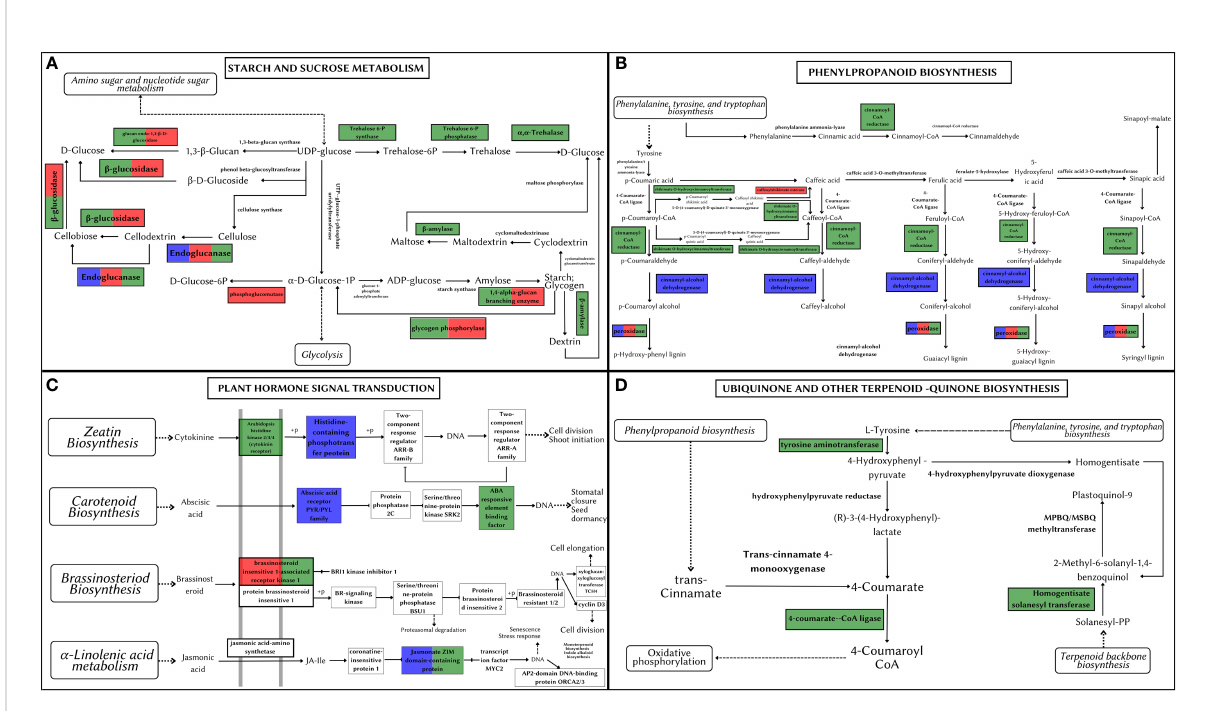
FIGURE 7 Metabolic pathways depicting positively selected genes in Artocarpus species. The positively selected genes in A. hirsutus (green), A. heterophyllus (blue), and A. altilis (red). (A) Starch and Sucrose Metabolism. (B) Phenylpropanoid biosynthesis. (C) Plant hormone signal transduction. (D) Ubiquinone and other-terpenoid-quinone